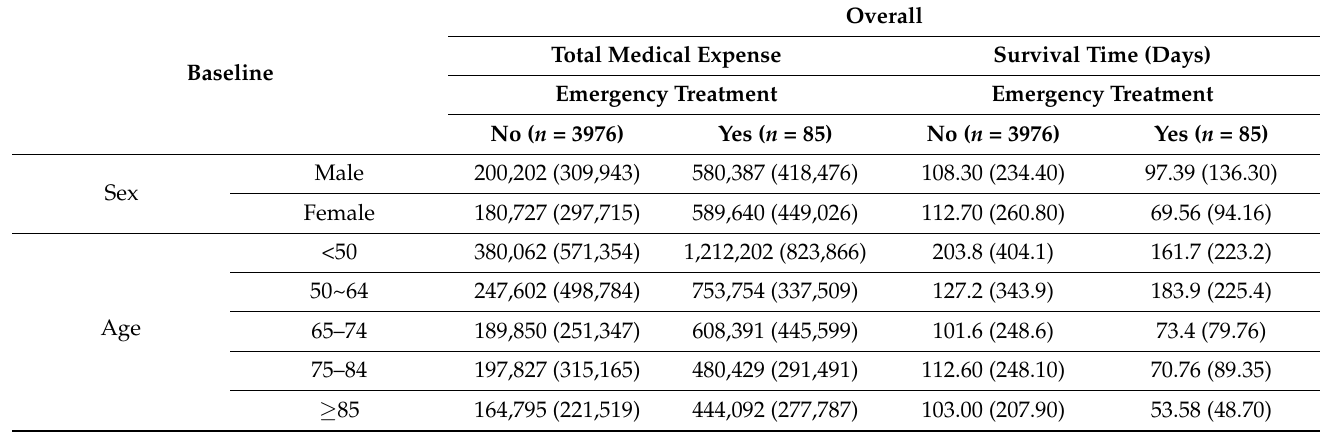
Table 3. Survival time and medical expense.